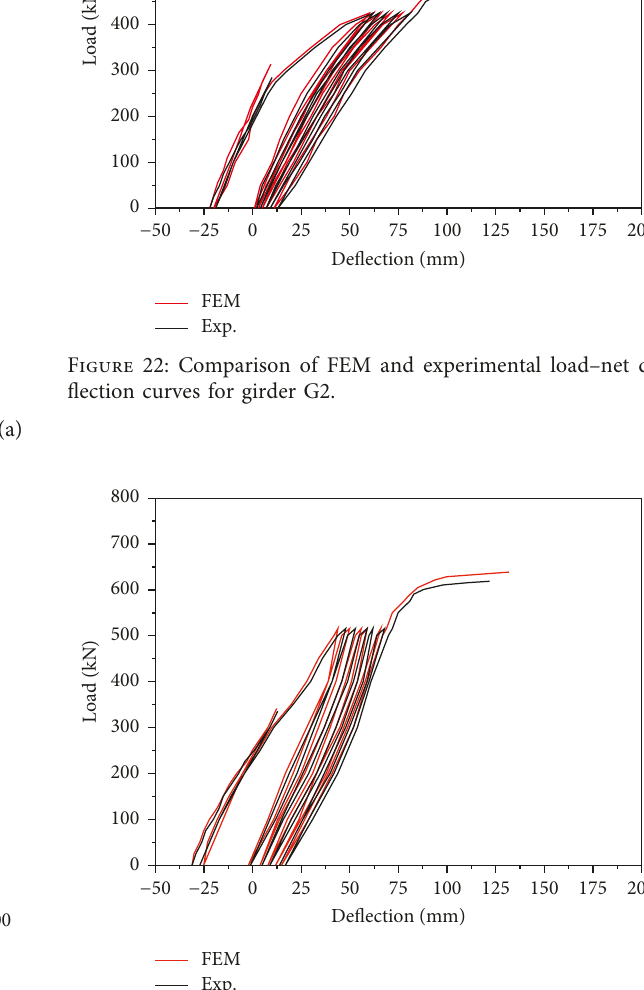
Figure 23: Comparison of FEM and experimental load–deflection curves for girder